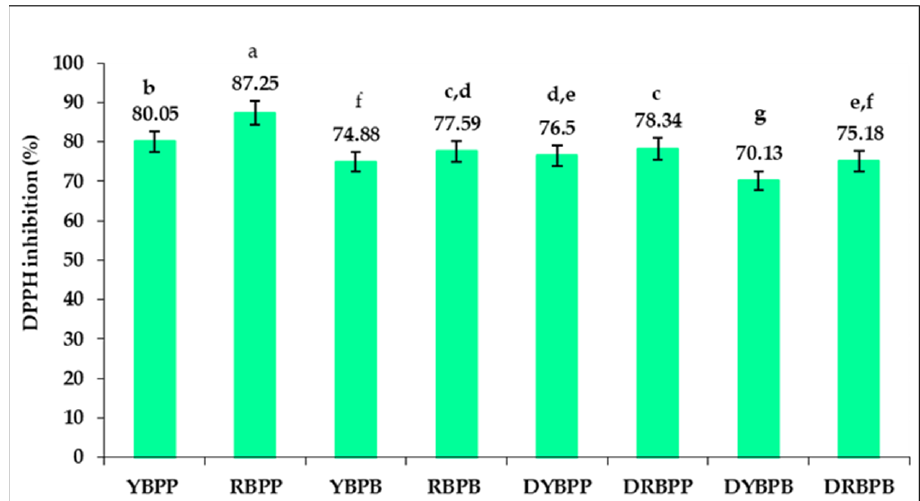
Figure 3. DPPH inhibition (%) of yellow and red bell pepper pulp and processing by-products, fresh and after drying. Results are expressed as the mean value of three determinations ± standard deviation (SD) indicated by the error bars. According to the t -test, different letters (a–g) represent significant differences ( p < 0.05) between the values represented in the columns.